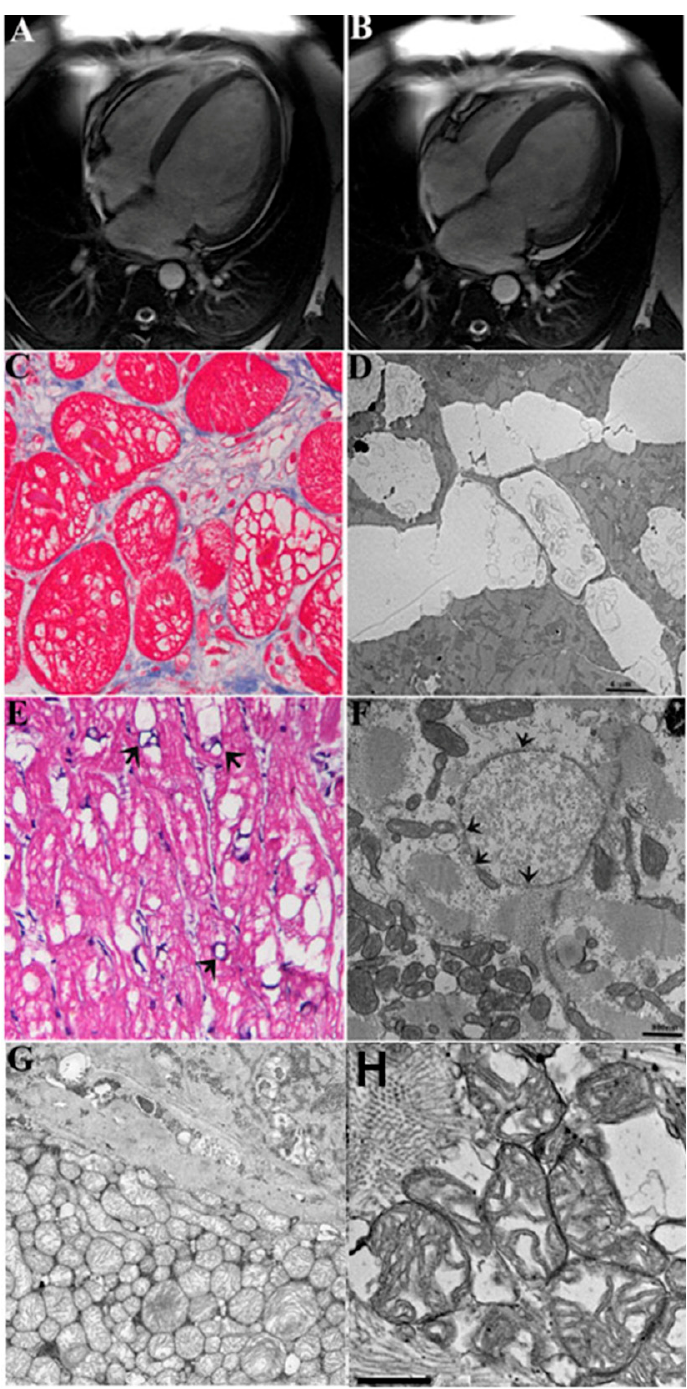
Figure 1. CMR, histologic, and ultrastructural changes of cardiomyocytes in a 45-year-old patient during heart failure caused by myocarditis. Panels ( A , B ): Cardiac magnetic resonance (CMR) showing bi-ventricular dilatation and severe dysfunction (LVEF 25%). Panels ( C – H ): LV endomyocardial biopsy showing vacuolar degeneration of myocytes ( C ) corresponding at electron microscopy to water accumulation in clear cisternae in the endoplasmic reticulum ( D ) (The bar represents 4 µ m), nucleus ( E , F ), the bar represents 800 nm) and vesiculated mitochondria ( G ) × 3000 original magnification; ( H )—The bar rep-resents 500 nm). In panel ( F ), remarkable nuclear edema causes chromatolysis and cell death; arrows indicate fragmentation of nuclear membrane. Further details of nuclear changes are better shown in Supplemental Figures S11 and S17.